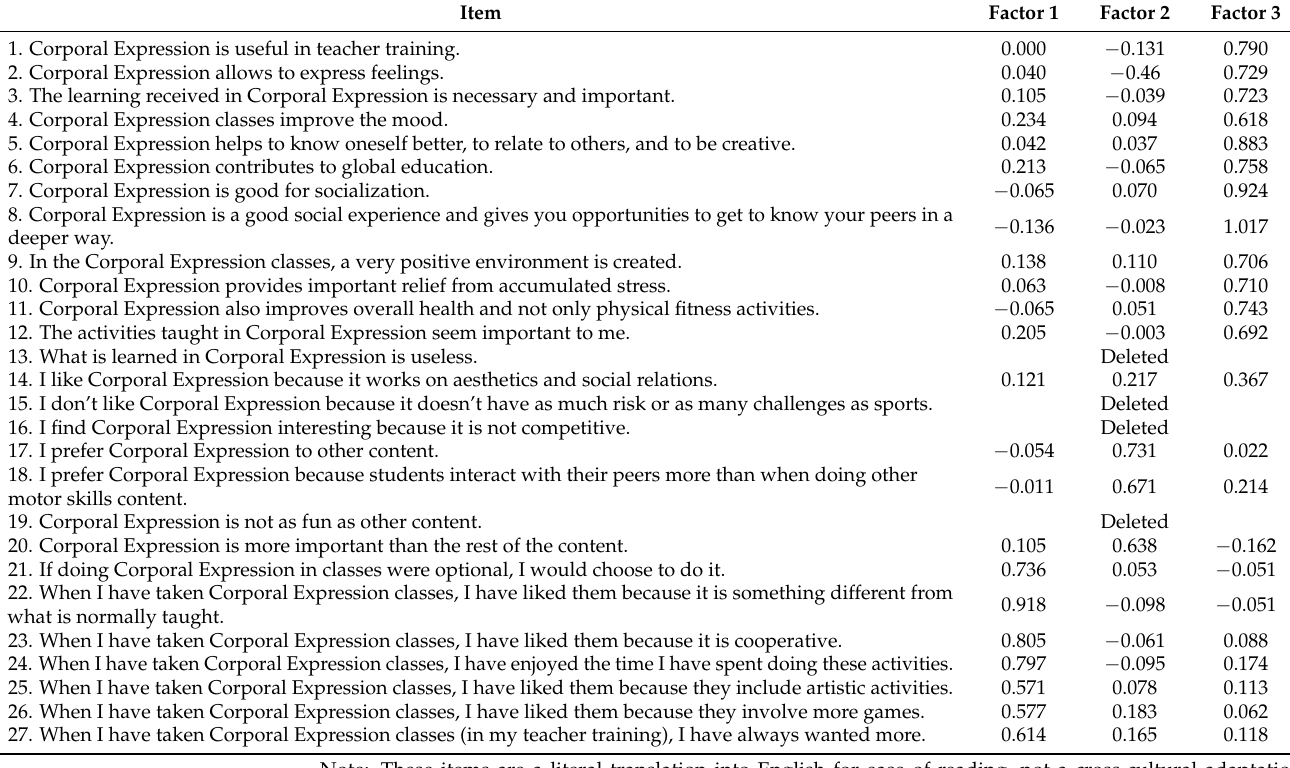
Table 2. Rotated loading matrix with normalized